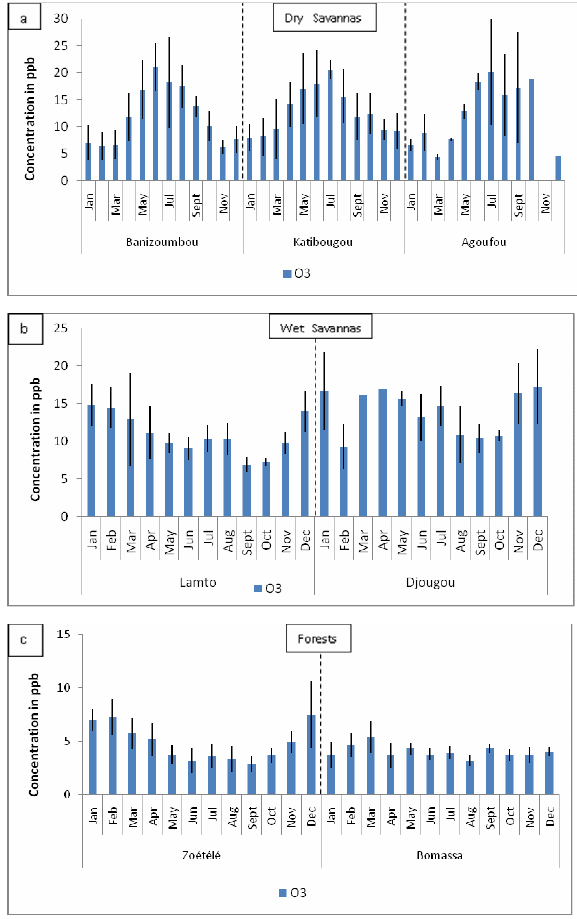
Figure 7 : Evolution of monthly O 3 concentrations on the transect dry savannas (7a), wet savannas (7b), forests (7c). Fig. 7. Evolution of monthly O 3 concentrations on the transect dry savannas (a) , wet savannas (b) , forests (c)